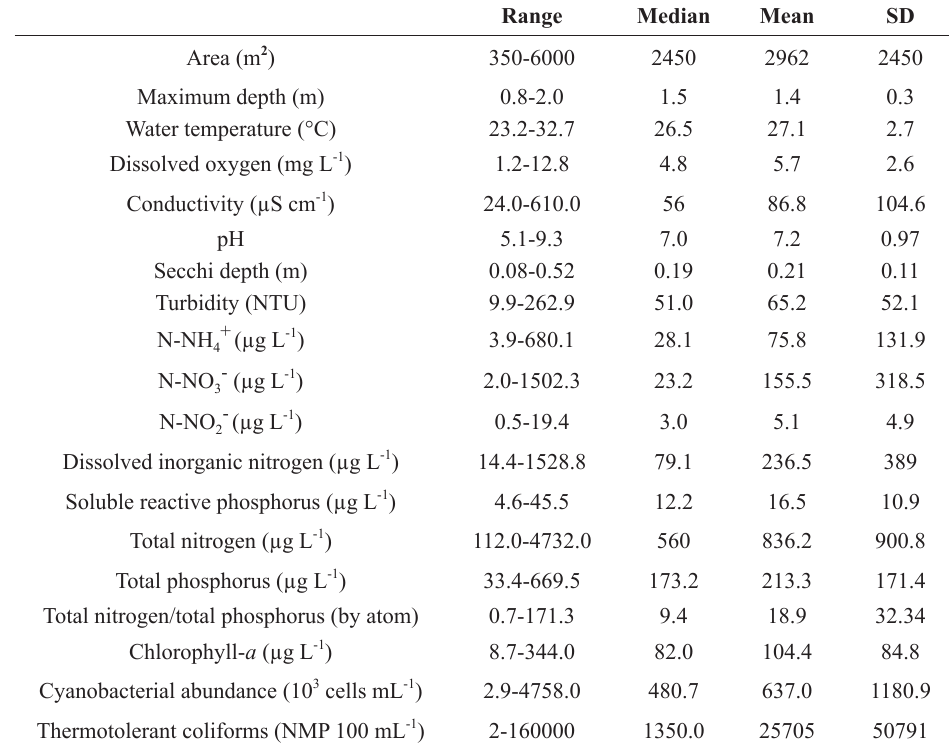
Range, median and mean values, and standard deviation (SD) of the limnological variables in 30